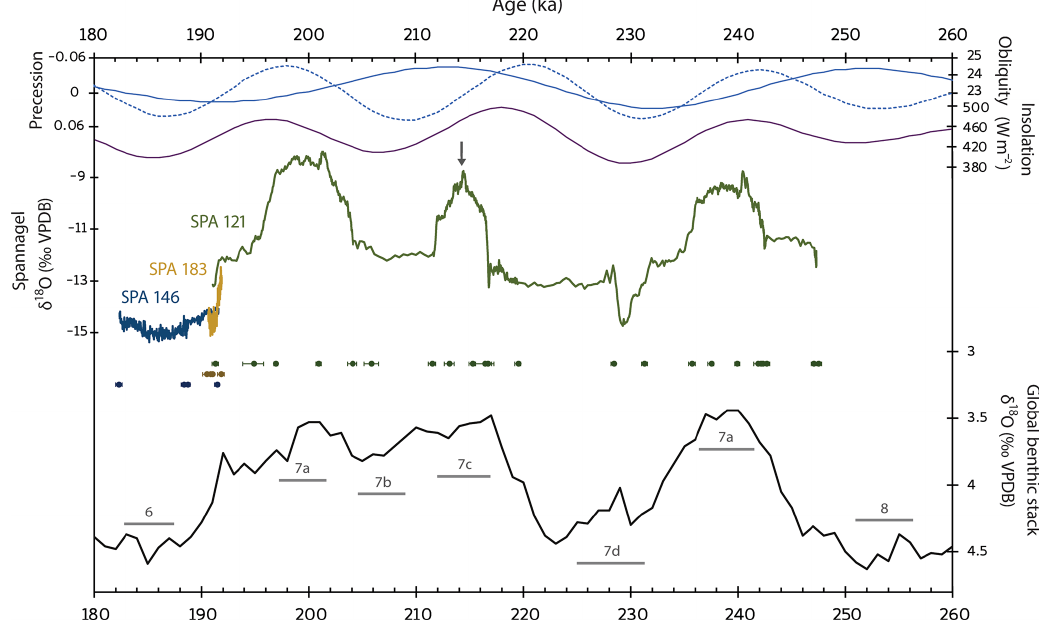
Figure 3. Obliquity (blue), precession (dashed blue), and 65 ◦ N July insolation (dark purple) from Berger (1978). Spannagel δ 18 O from stalagmites SPA121 (green), SPA183 (yellow), and SPA146 (dark blue) (this study). Global stacked benthic δ 18 O (black; Lisiecki and Raymo, 2005) plotted with MIS substage labels (gray) for reference. Arrow represents the age of fluorescent inclusions, which suggest a partial retreat of the Hintertux Glacier (214.3 ± 0 .